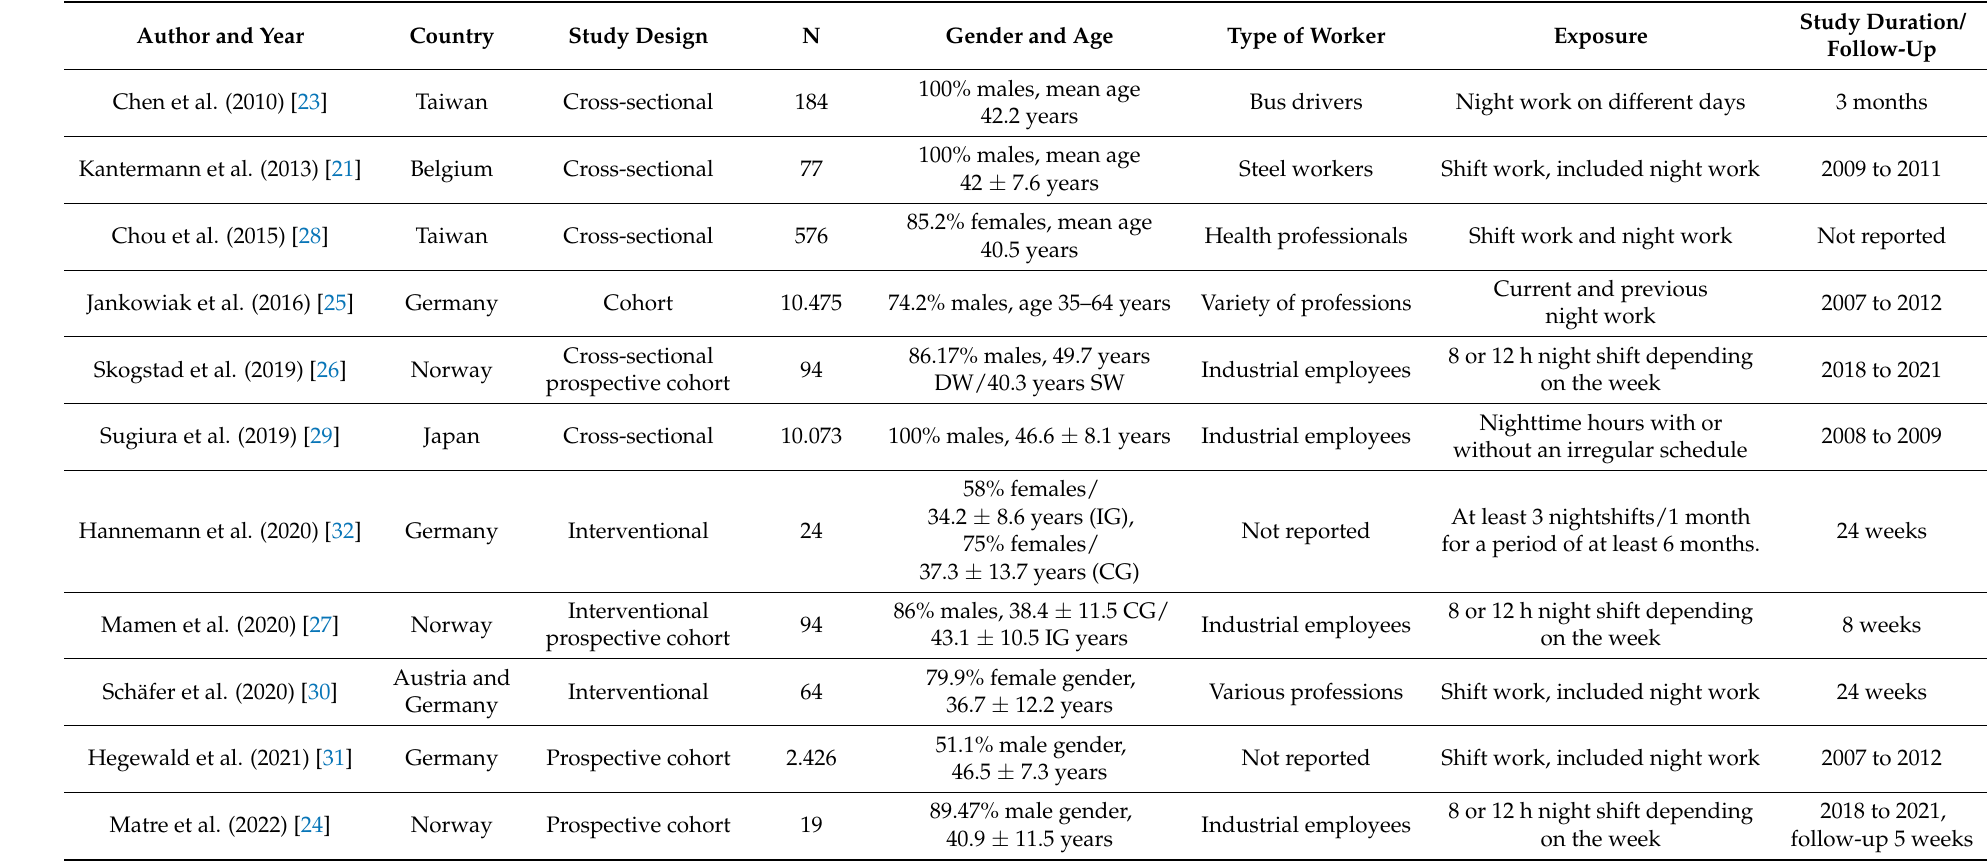
Table 3. Characteristics, type of exposure and duration or follow-up of studies selected for inclusion in